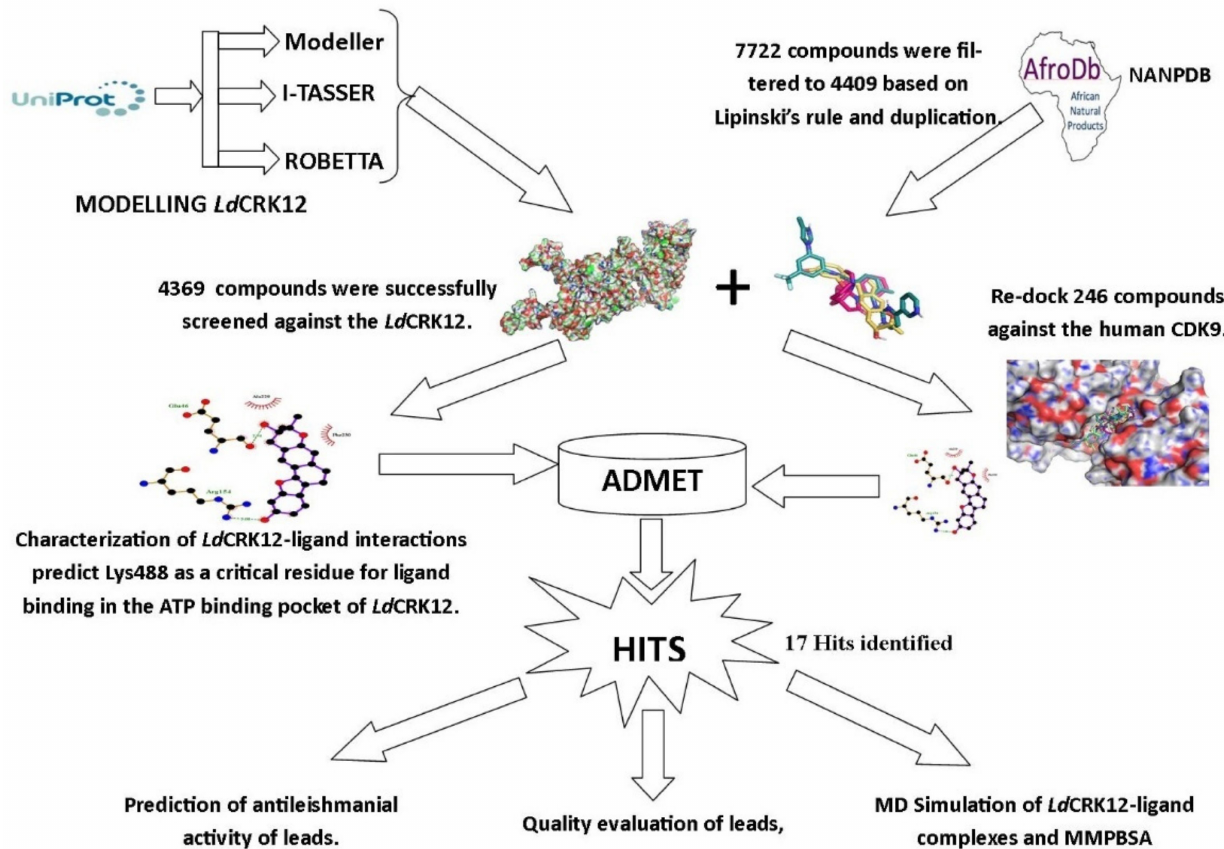
Figure 1. Methodology schema employed in this study for predicting potential antileishmanial compounds. Three modelling techniques comprising Modeller [29,30], I-TASSER [31–34] and Robetta [35–37] were used to predict potential Ld CRK12 structures. Evaluation of the predicted protein structures revealed the reasonably best model. Natural compounds from the African Natural Product Database (AfroDB), as well as the North African Natural Product Database (NANPDB) and known antileishmanial compounds, were docked against Ld CRK12 and the human CDK9 receptors. The potential lead compounds were subjected to absorption, distribution, metabolism, excretion, and toxicity (ADMET), biological activity predictions, and molecular dynamics (MDs)